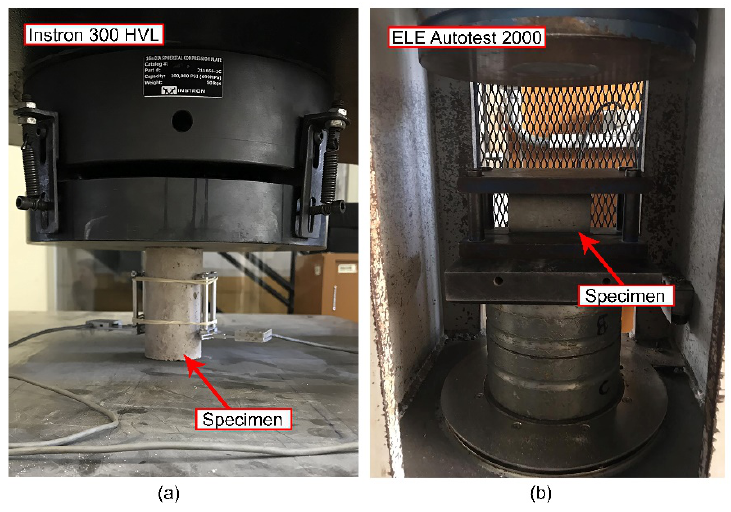
Figure 3. Bedding mortar: (a) compression and (b) tensile tests.